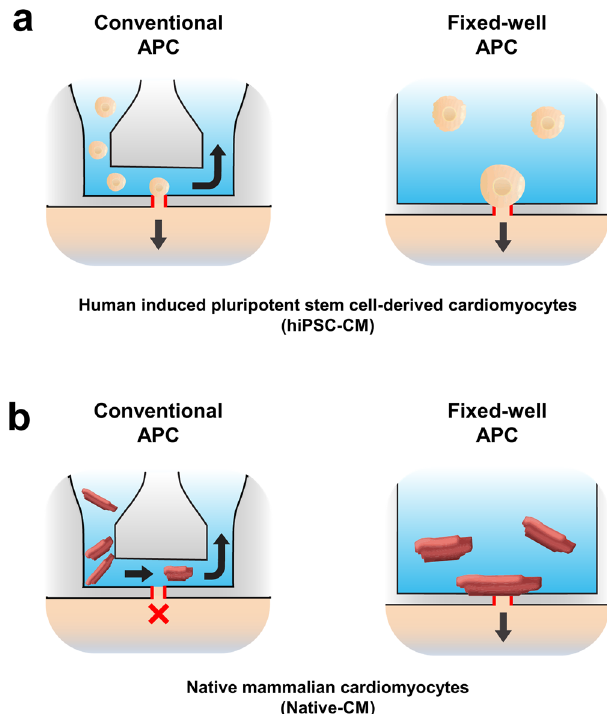
Fig. 1 Simpli fi ed cross-sectional schematic of conventional micro fl uidic automated patch-clamp (APC) and fi xed-well APC during assays with cultured cellular systems such as human induced pluripotent stem cell- derived cardiomyocytes (hiPSC-CM) or native mammalian cardiomyocytes (Native-CM). a Schematic of hiPSC-CMs within APC systems. In a micro fl uidic APC system, cells and external bath solution are pipetted into the inlet well and travel through the channel to settle on the patch-clamp aperture (outlined in red). Waste liquid sequestration allows for fast fl ow-through perfusion and drug application (lateral arrow). In a fi xed-well APC system, cells and bath solution are pipetted into the chamber and through gravity and suction are allowed to settle on the patch-clamp aperture (outlined in red). b Native cardiomyocytes within a micro fl uidic system cannot successfully reach or settle on the patch-clamp aperture due to size, sample debris, or high resistance channel-enhanced fl uid velocity. These features are not present in a fi xed well APC chamber. Cleanly isolated Native CMs can settle on the patch-clamp aperture for adequate seal formation and electrophysiological